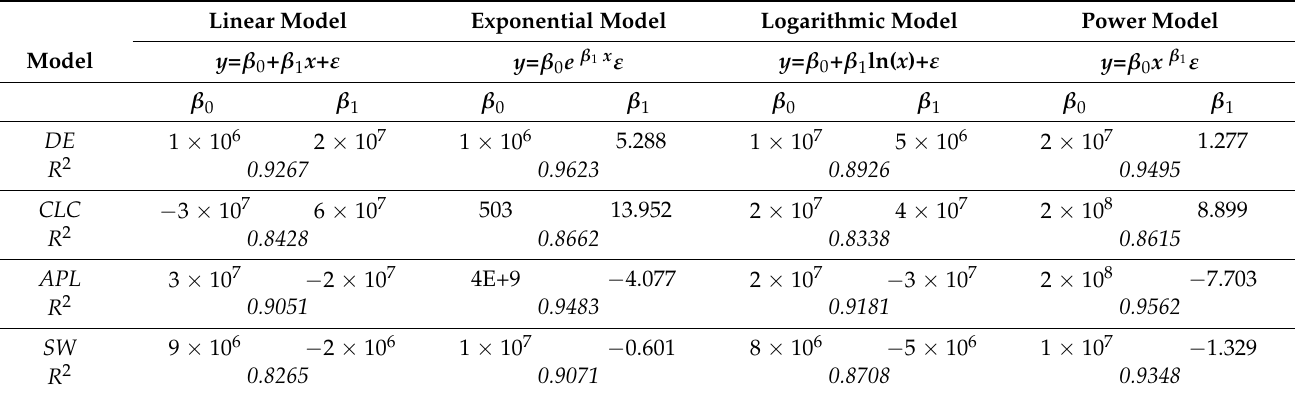
Table 4. The fitting models test of different metrics and